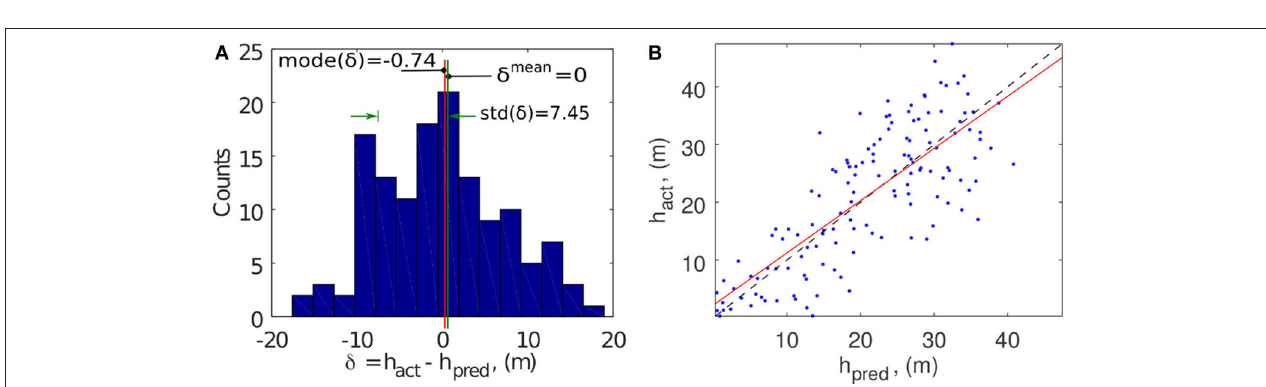
FIGURE 7 | Landslide FID5. (A) Histogram of δ ( x , y ), the graphical definition of mode( δ ), std( δ ) and the negligible mean depth discrepancy δ mean . (B) Scatter plot and regression analysis of the predicted and actual depths.